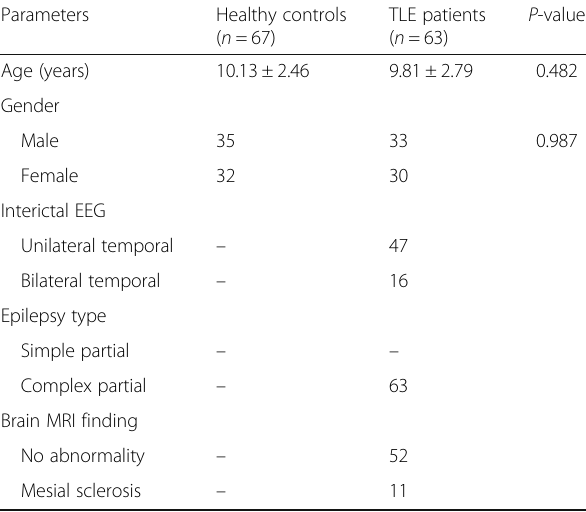
Table 1 Clinical characteristics of the patients with TLE and